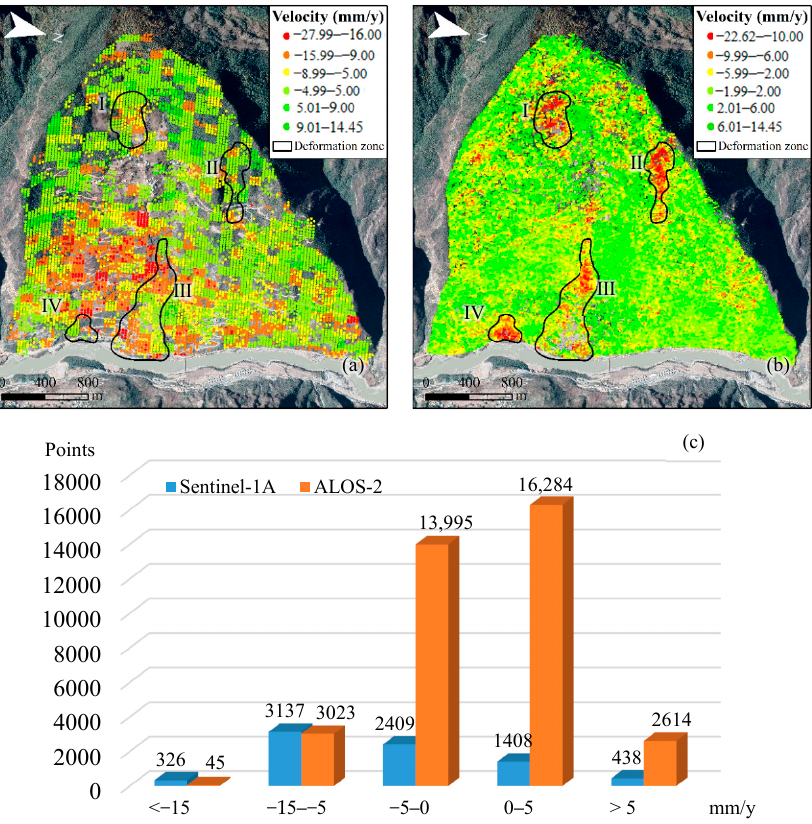
Figure 8. Deformation details and features of the KZG landslide with different data: ( a ) Sentinel-1A data, ( b ) ALOS-2 data, and ( c ) statistical diagram of deformation points.